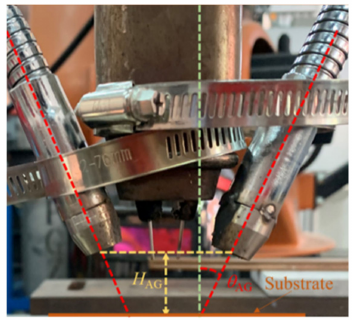
Figure 3. Position diagram of auxiliary gas nozzle and welding